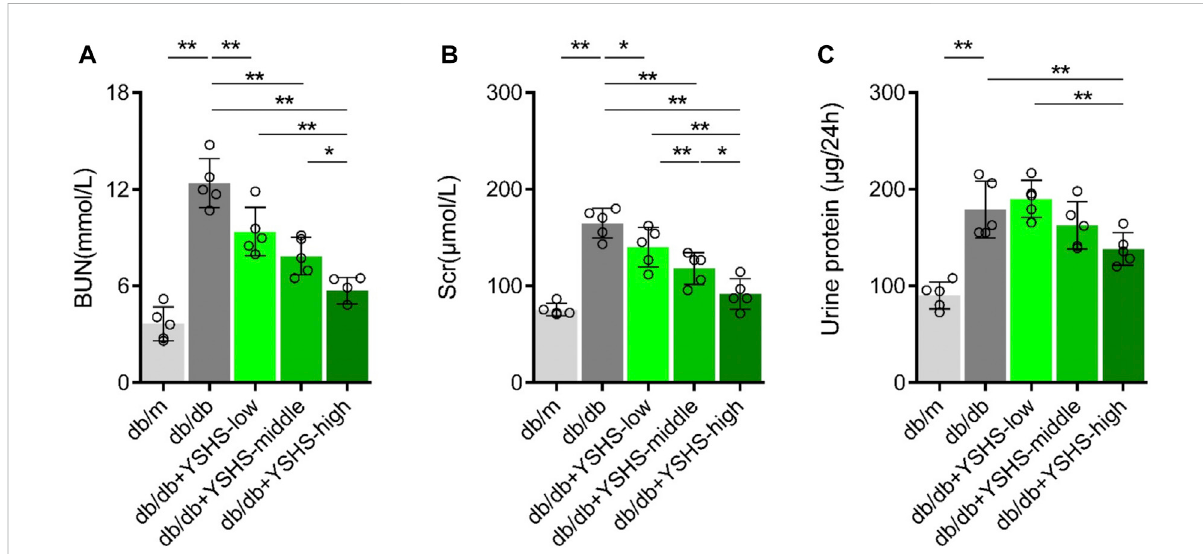
FIGURE 1 Effects of YSHS on renal function and proteinuria in db/db mice. (A-C) Measurement of Serum Scr, BUN levels, and 24-h-urine protein in db/m mice and db/db mice with or without a YSHS treatment. Data analysis adopts one-way ANOVA analysis of variance, and error bars indicate SD.* p < 0.05 and ** p < 0.01. YSHS-low, YSHS-middle, and YSHS-high indicate the low-dose group, middle-dose group, and high-dose group of Yi-Shen- Hua-Shi granules drugs dose,